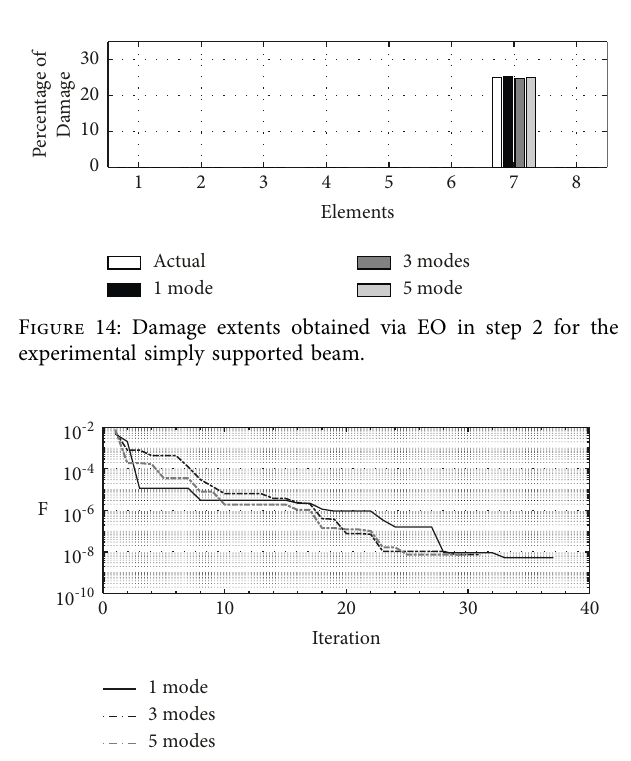
Figure 15: Convergence rate of the EO algorithm for the exper- imental simply supported beam. Table 9: Material and physical properties of the experimental simply supported